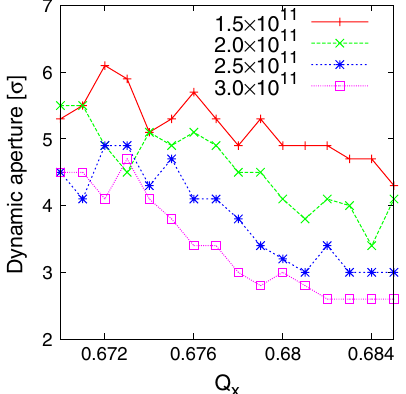
FIG. 11. Dynamic apertures of half head-on beam-beam com- pensation in the scan of proton working point. The horizontal axis is the fractional horizontal zero-amplitude tune. The frac- tional vertical zero-amplitude tune is always 0.01 higher than the horizontal